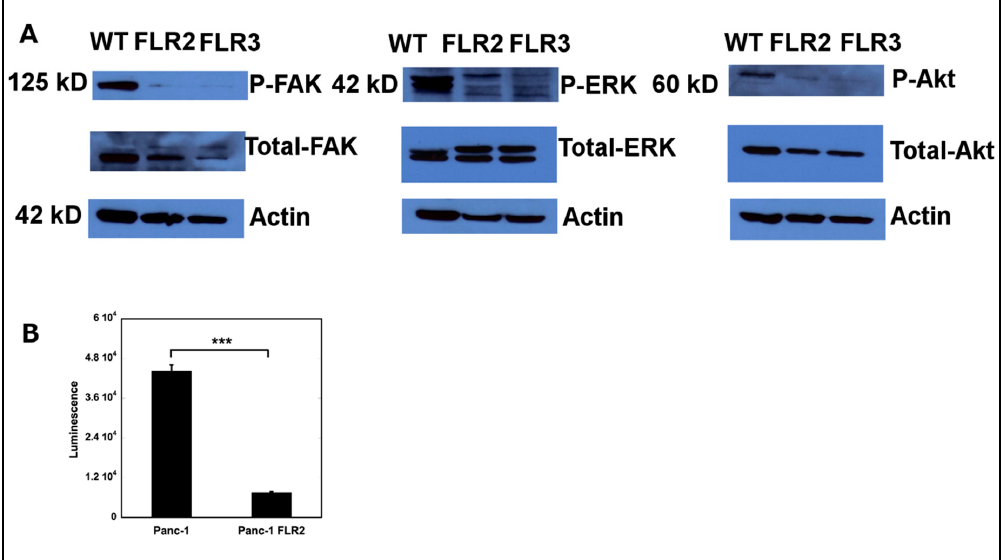
Figure 6. ( A ) RAGE expression in FLR2 Panc ‐ 1 cells affects cell signaling. Expression levels of ERK1/2 and pERK1/2, Akt and P ‐ Akt, FAK, and P ‐ FAK in WT, FLR2, and FLR3 Panc ‐ 1 cells as determined by Western blot analysis. Actin was used as a loading control. Representative blots are shown. ( B ) RAGE expression in FLR2 Panc ‐ 1 cells results in decreased NK ‐κ B activity. NK ‐κ B activity assay using an